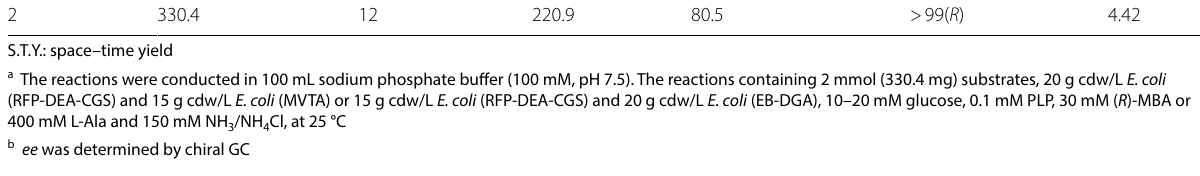
Figure S3. SDS-PAGE of the cell-free extracts of recombinant E. coli cells co-expression of multiple enzymes. A: lane M ： marker, lane 1, 2 ： E. coli